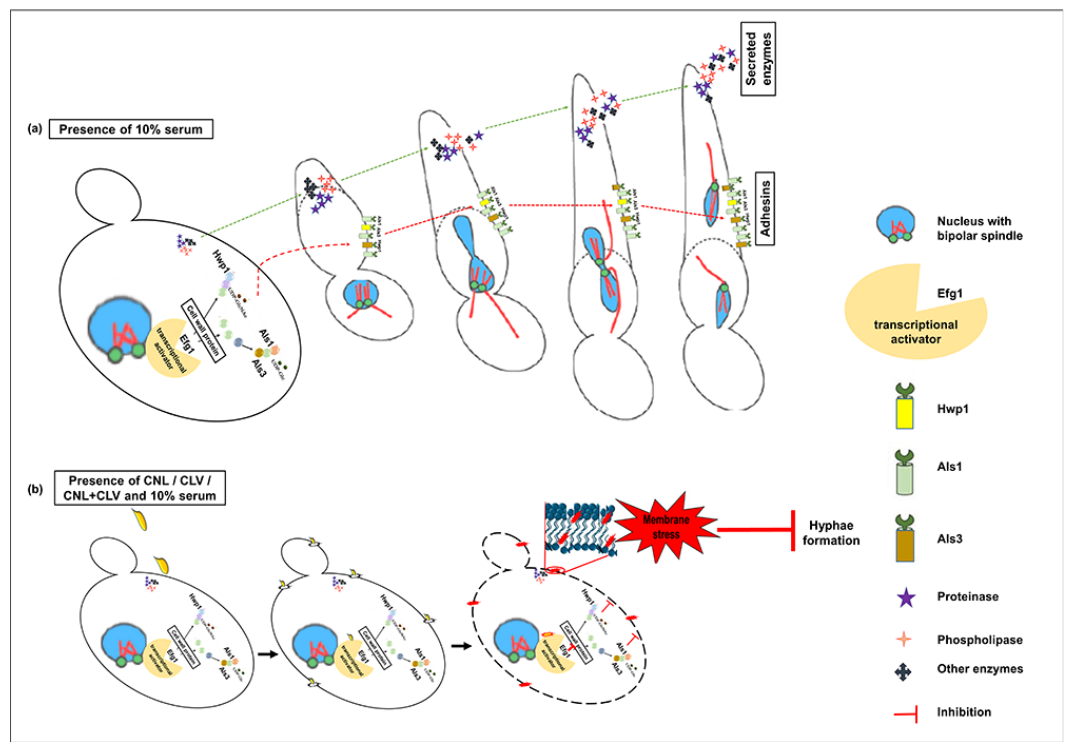
Figure 4. Model of the impact of CNL and CLV on C. albicans hyphal development. ( a ) Serum normally triggers the yeast-to-hyphal transition at 37 ◦ C, which requires transcription factors such as Efg1 that play a major role in the expression of cell wall adhesion proteins (Hwp1, Als1, Als3, etc.). Subsequent hyphal elongation involves Hgc1, Eed1, and Ume6, of which Eed1 and Ume6 are negatively regulated by Tup1 and Nrg1 [66]. Hyphal initiation enables hydrolytic enzyme secretion, including proteinases (Sap), phospholipase B enzymes, and lipases, which play an important role in the pathogenicity of candidiasis. ( b ) At sublethal levels, we propose that the lipophilic EOs cause membrane stress that impacts cell wall proteins and secreted enzymes, thereby perturbing hyphal